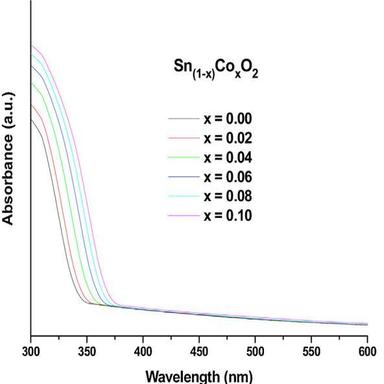
Typical absorbance spectra of Sn1−xCoxO2 (with 0 ≤ x ≤ 0.10) nanoparticles.